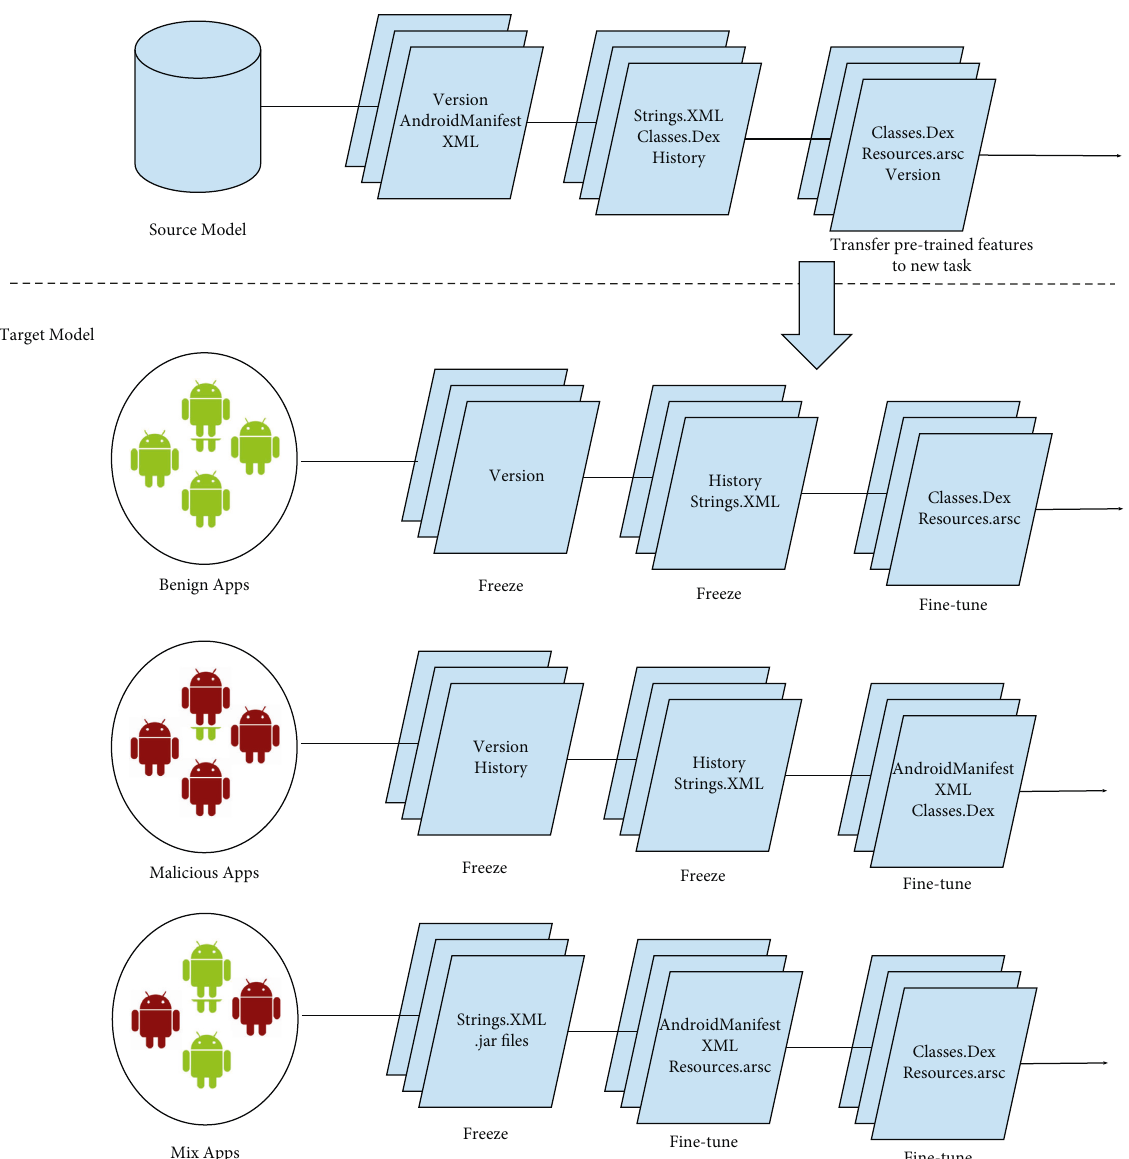
Figure 7: Layers upgradation in transfer learning mechanism.